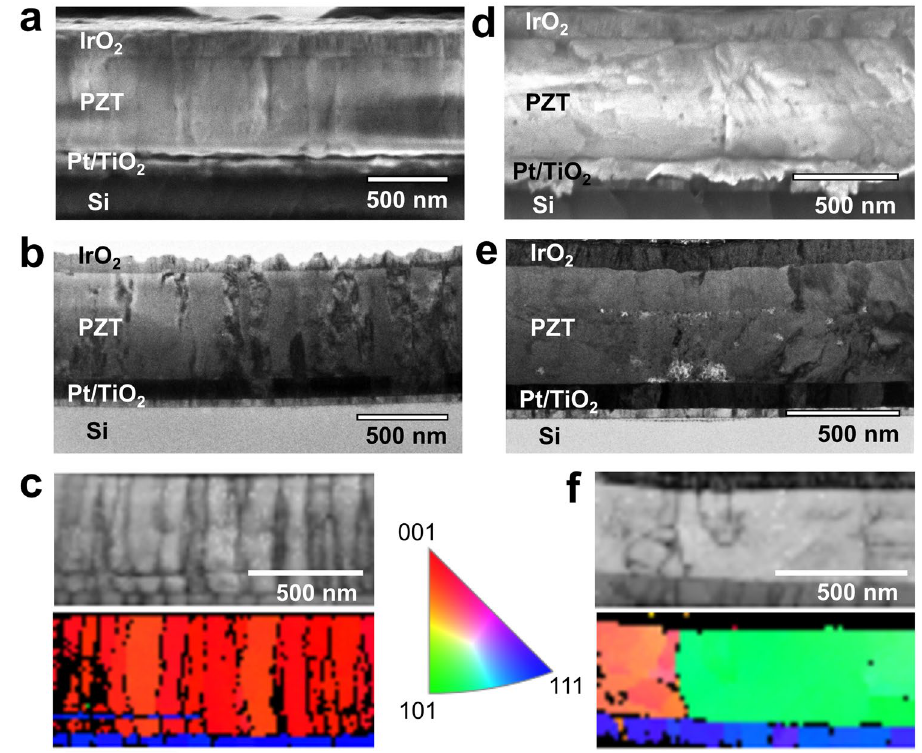
Figure 3. Microstructural characterization of PZT thin films with columnar and equiaxed grains. ( a , d ) SEM, ( b , e ) TEM, and ( c , f ) TKD cross-sectional images of columnar-grained films ( a , b , c ) processed using 2-methoxyethanol-based precursor PZT solution, and equiaxed-grained films ( d , e , f ) prepared using a methanol-based inverted mixing order PZT precursor solution. Note that the crystallographic poles noted for the pole figure are relative to the film normal (verticle direction in the